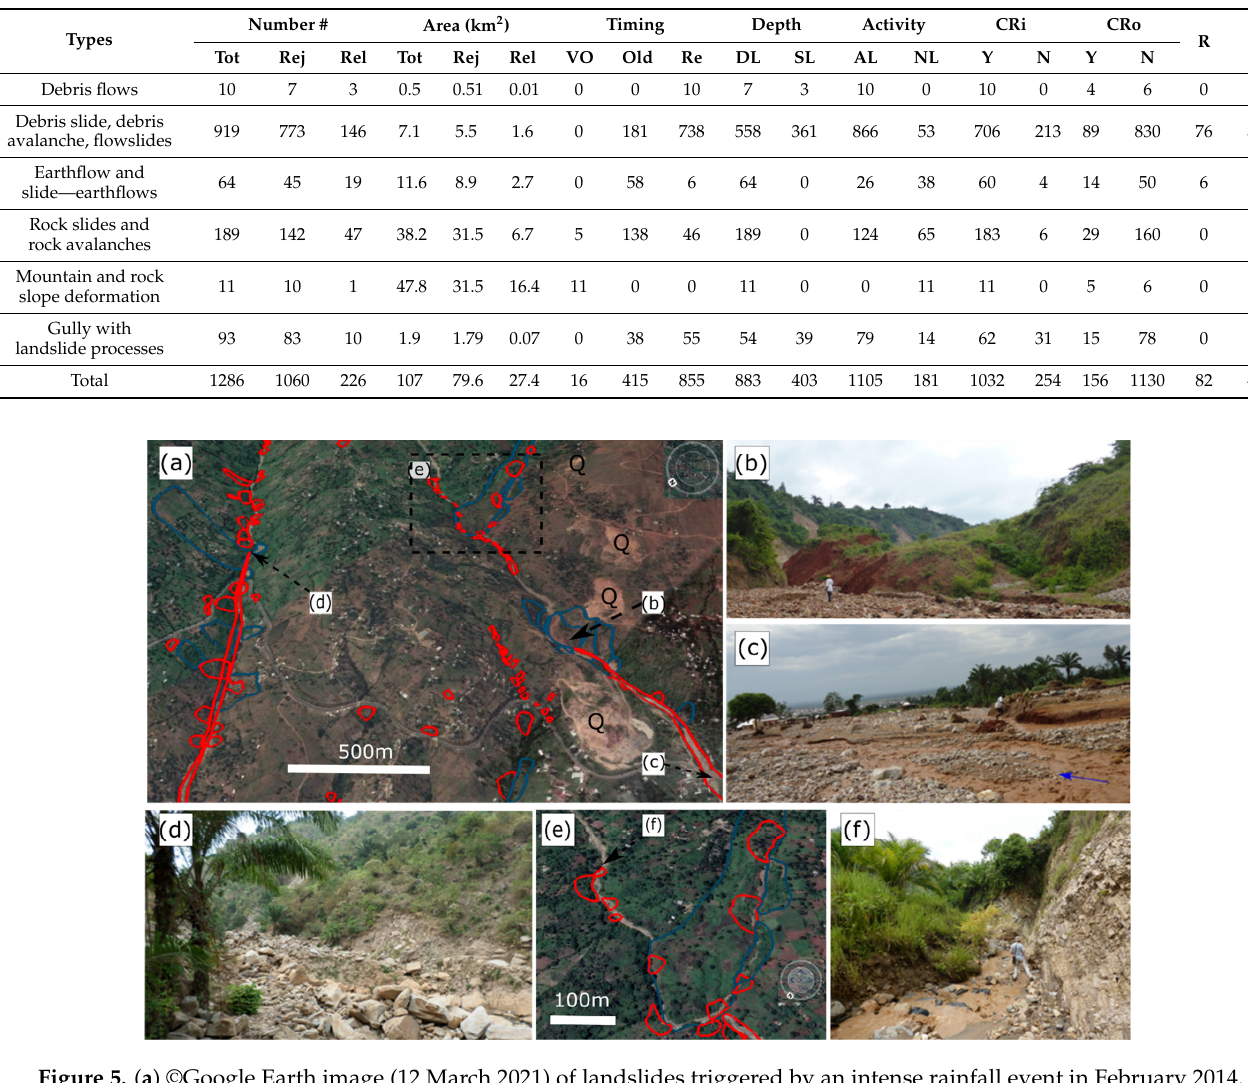
Table 2. Main characteristics of the landslides and gullies inventoried. CRi: connected to river; CRo: connected to road; R: reactivation; LR: landslide related to river bank/road cut; Tot: total; Rej: rejuvenated landscape; Rel: relict landscape; VO: very old landslide; Re: recent landslide; DL: deep-seated landslides; SL: shallow landslides, AL: active landslides; NL: non-active landslides; Y: yes, N: no; NA: not applicable.